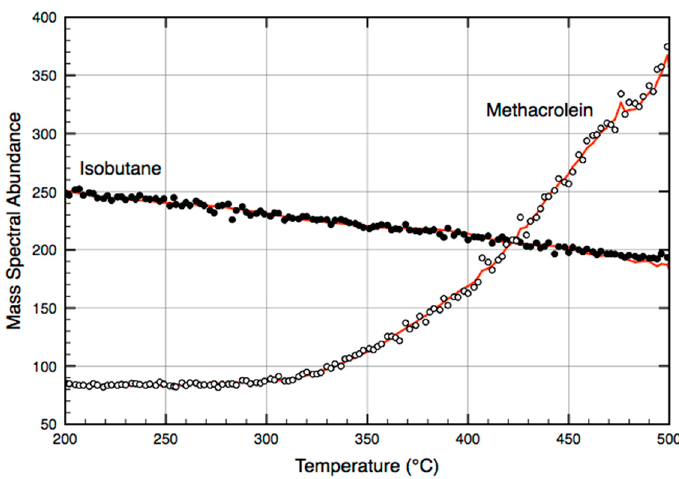
Figure 1. Isobutane mass spectral abundance (filled circles) and methacrolein abundance (open circles) as a function of temperature, both with weight average wavelet denoised lines (red lines) during temperature-programmed oxidation of isobutane over phosphomolybdic acid (3 rd run).